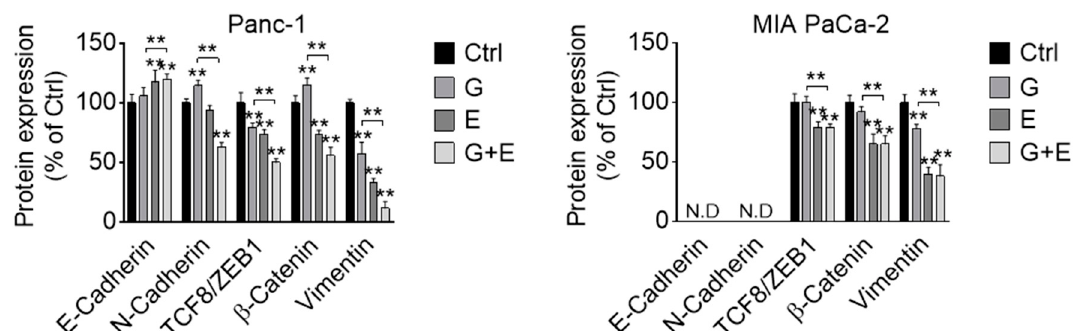
Figure 7. EGCG enhances sensitivity of gemcitabine on Akt and EMT pathway inhibition. ( a ) Co-treated with EGCG (E), the suppression e ff ect of gemcitabine (G) on Akt pathway is enhanced. Immunoblots for phosphorylated / total IGFR, phosphorylated and total PI3K, and phosphorylated and total Akt in whole cell protein extracts from Panc-1 and MIA PaCa-2 cells treated with EGCG (E), gemcitabine (G), or both (G + E) for 12 h. Loading control: β -Actin. Bands were quantified and results are expressed as a percentage of control. * p < 0.05, ** p < 0.01 vs. control. ( b ) EGCG plus gemcitabine further inhibit EMT. Immunoblots for E-Cadherin, N-Cadherin, TCF8 / ZEB1, β -catenin, and Vimentin in whole cell protein extracts from Panc-1 and MIA PaCa-2 cells treated with EGCG (E), gemcitabine (G), or both (G + E), for 48 h. Loading control: β -Actin. Bands were quantified and results are expressed as a percentage of control. ** p < 0.01 vs. control.